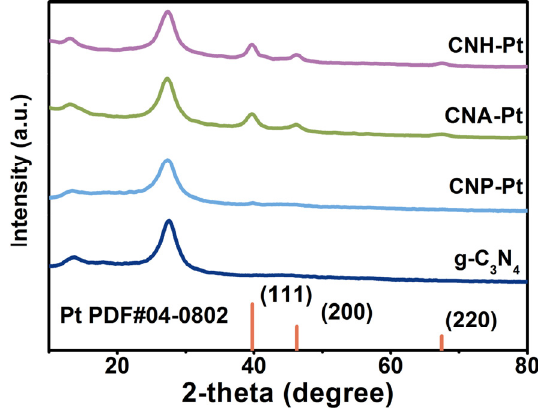
Figure 1. XRD patterns of the catalysts.